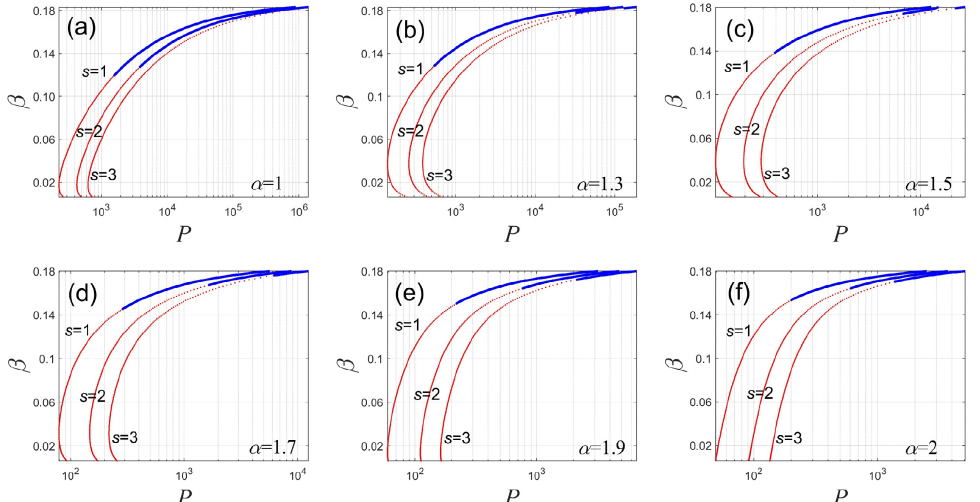
Figure 11. The propagation constant, β ≡ − µ , vs. the norm (power) of the 2D solitons with vorticities s = 1,2 and 3. The power is defined here as P ≡ 2 2/ α N 2D , as shown in Equation (40). The results are produced by the numerical solution of Equation (38) for fixed values of the Lévy index: α = 1 ( a ), 1.3 ( b ), 1.5 ( c ), 1.7 ( d ), 1.9 ( e ), and 2 ( f ). The latter case, corresponding to the usual two-dimensional NLSE, is included for comparison with the results produced by the fractional diffraction. Note that values of the power are shown on the logarithmic scale, which is different in different panels. Blue and red segments represent stable and unstable vortex states, respectively. Reprinted with permission from Reference [31]. Copyright 2020